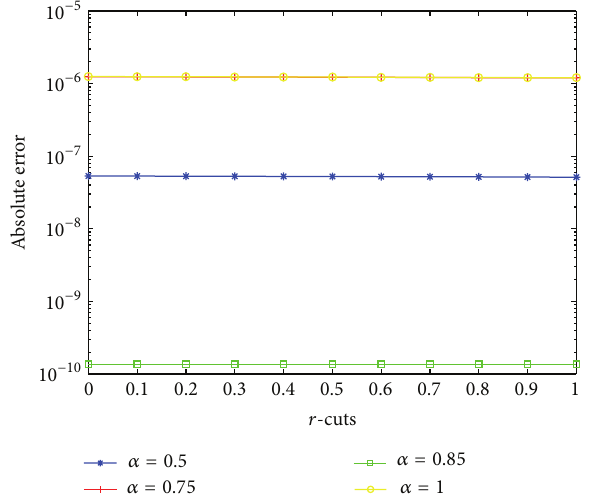
Figure 10: The absolute error for different values 𝛼 with V = 0.85 , = 0.014 , 𝑚 = 10 , and 𝑘 𝑘 1